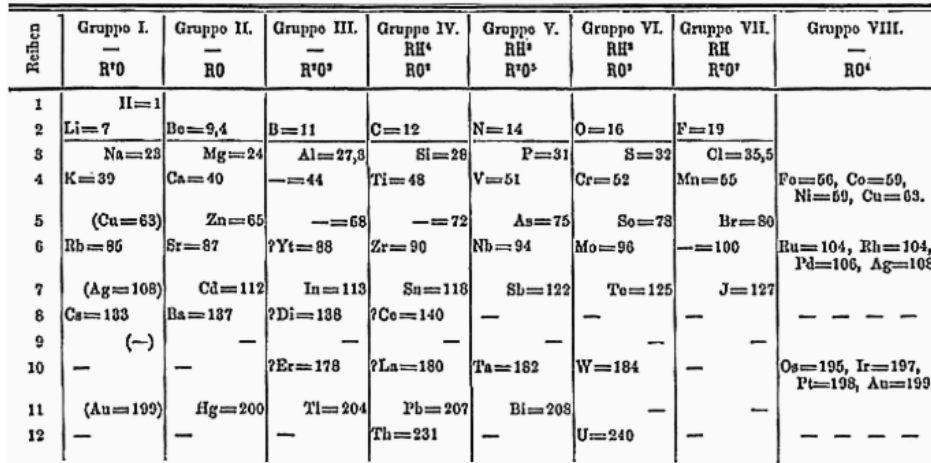
Figure 2. Mendeleev’s second Table of 1871 taken from ref. 3 (p.